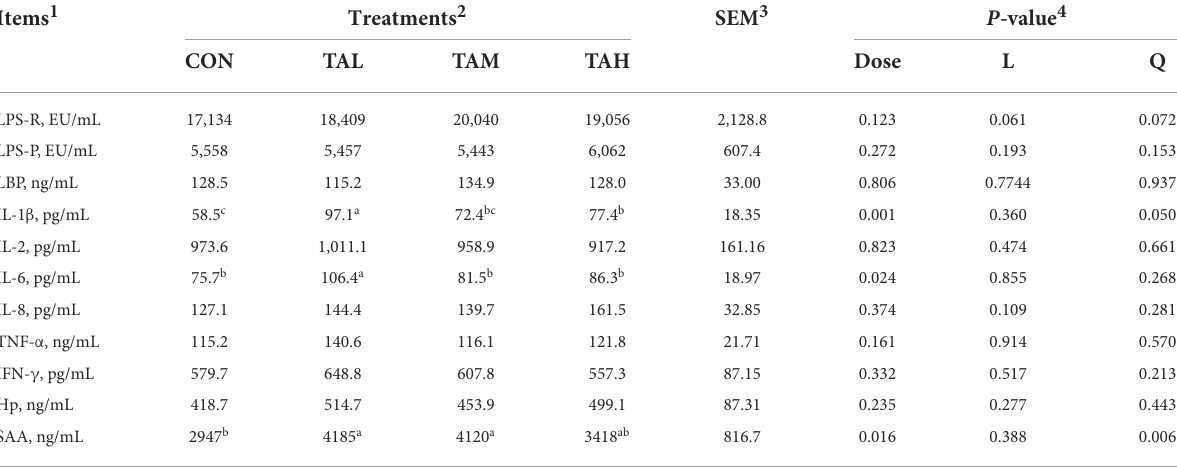
TABLE 5 Effects of tannic acid at different doses on lipopolysaccharide endotoxin in the rumen liquid and plasma, and relevant inflammatory indicators in the serum of black goats. Items 1